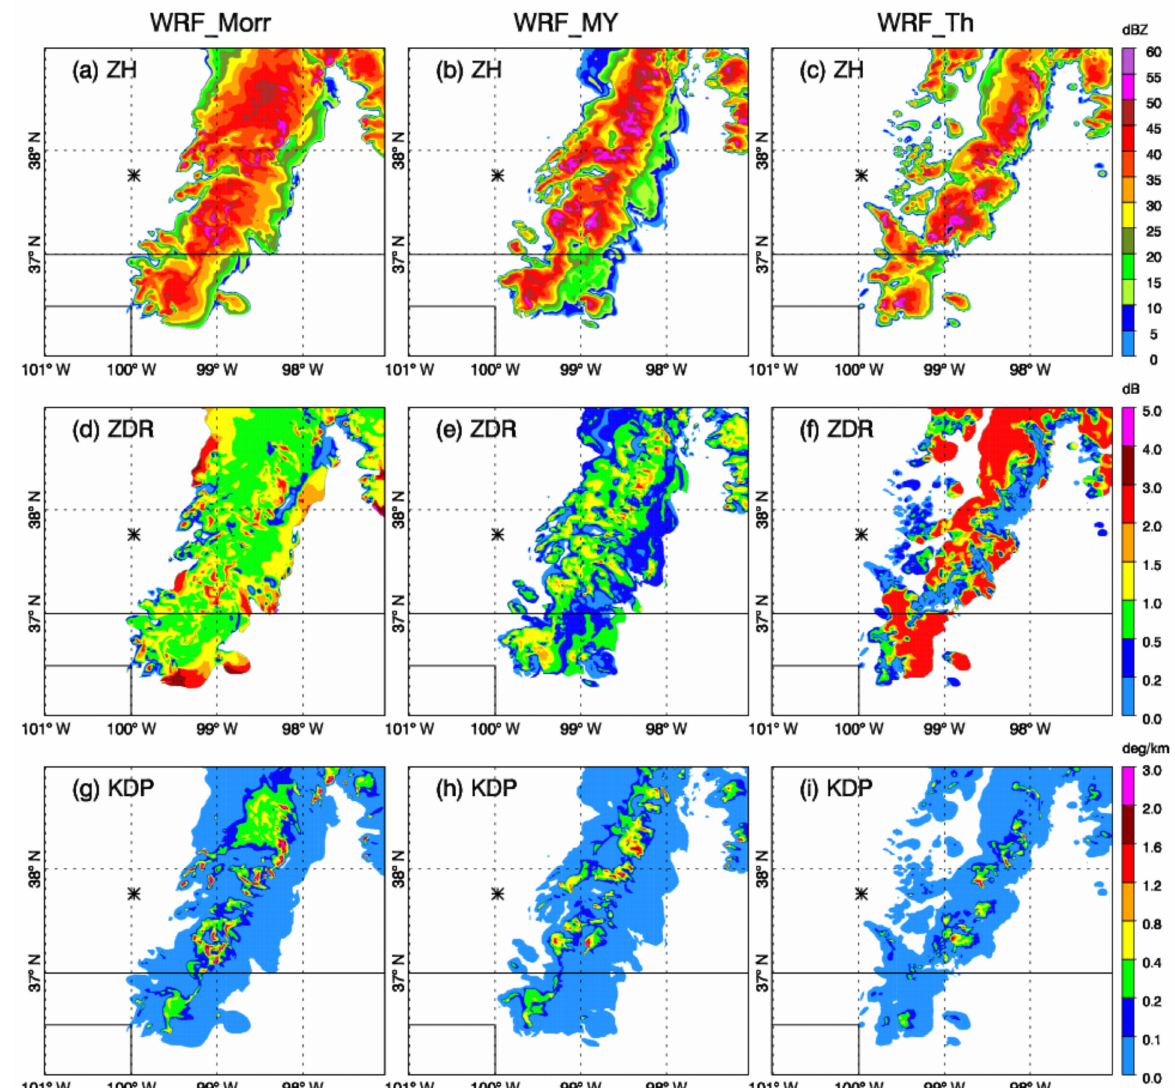
Figure 8. Z H ( a – c ), Z DR ( d – f ), and K DP ( g – i ) for WRF_Morr, WRF_MY, and WRF_Th, respectively. All plots are for the fields at 2345 UTC 29 May 2018 at 3 km height. The star signs in the plots show the location of the KDDC